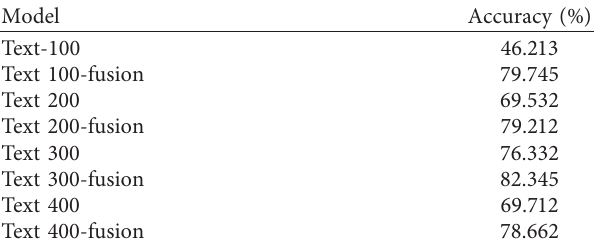
Figure 5: Preference distribution of the six topics across periods. Table 7: Accuracy of different presentation dimensions of the text features.